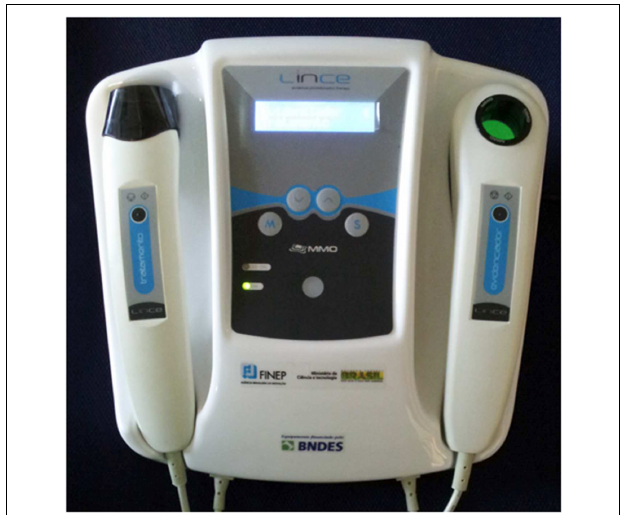
FIGURE 1 | Illumination system and optical diagnosis (Lince) to photodynamic therapy procedure.